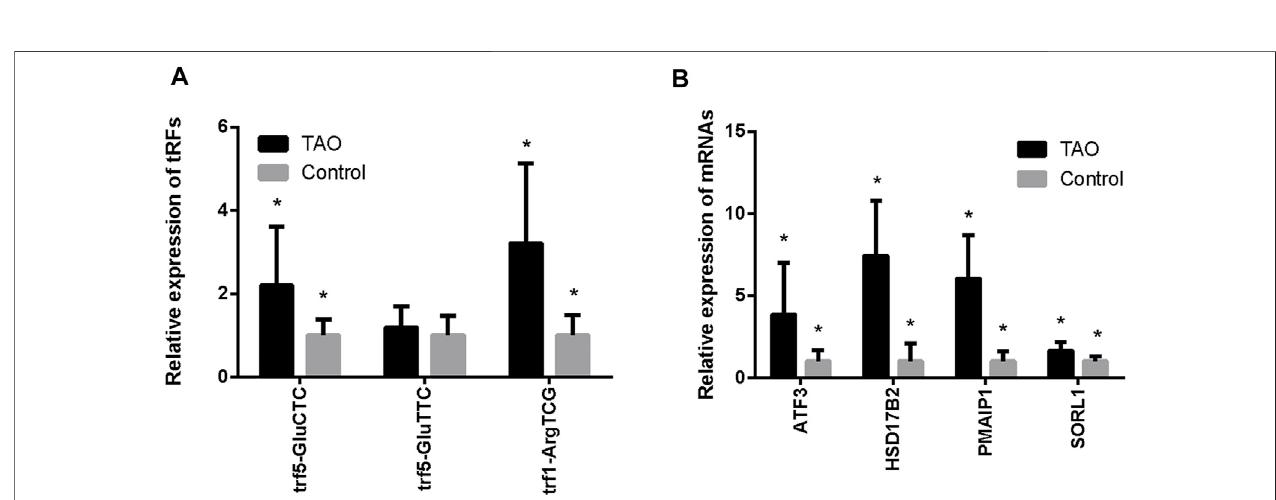
FIGURE 4 | Validation of expression levels of tRFs and intersecting mRNAs in the TAO group and the normal group. (A) Expression levels of tRFs detected by q-PCR. (B) Expression levels of mRNAs detected by q-PCR (* p < 0.05).